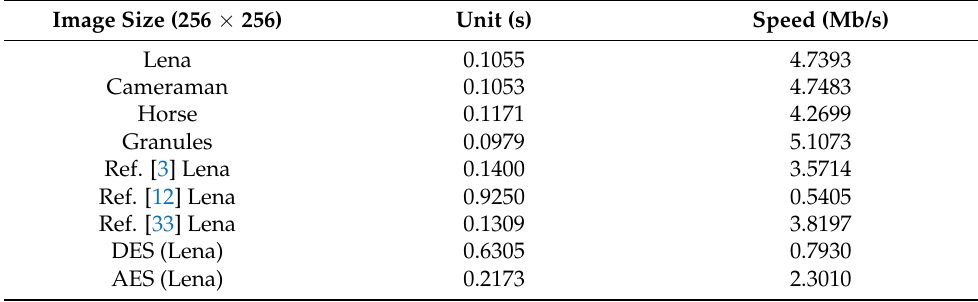
Figure 20. Robustness analysis ( a ) 10.00% salt & pepper noise of ciphered Lena; ( b ) decrypted result of ( a ); ( c ) 30.00% salt & pepper noise of ciphered Lena; ( d ) decrypted result of ( c ); ( e ) 10.00% data loss of ciphered Lena; ( f ) decrypted result of ( e ); ( g ) 30.00% data loss of ciphered Lena; ( h ) decrypted result of ( g ). Table 5. Encryption and decryption speed